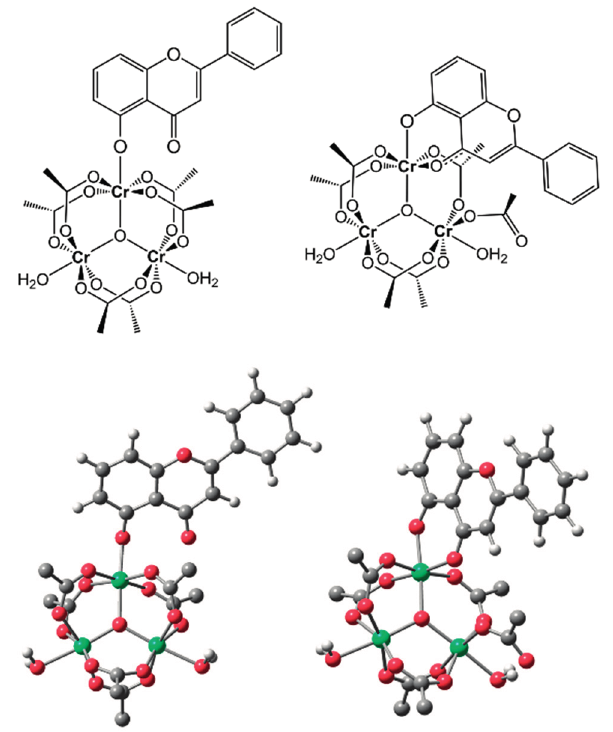
Figure 2. Drawing ( top ) and fully optimized density functional theory (DFT) structures ( bottom ) of the monodentate ( left ) and bidentate ( right ) isomers of the trinuclear Cr(III) complex with primuletin, formally [Cr 3 O( μ -CH 3 CO 2 ) 6 ( O 5 -Pri)(H 2 O) 2 ] and [Cr 3 O( μ -CH 3 CO 2 ) 5 (CH 3 CO 2 )( O 5 ,O 4 -Pri)(H 2 O) 2 ], respectively (the hydrogen atoms of acetate groups are omitted for clarity; color legend: Cr = green, O = red, and C = dark gray). Selected structural parameters are provided as Supplementary Material (Table